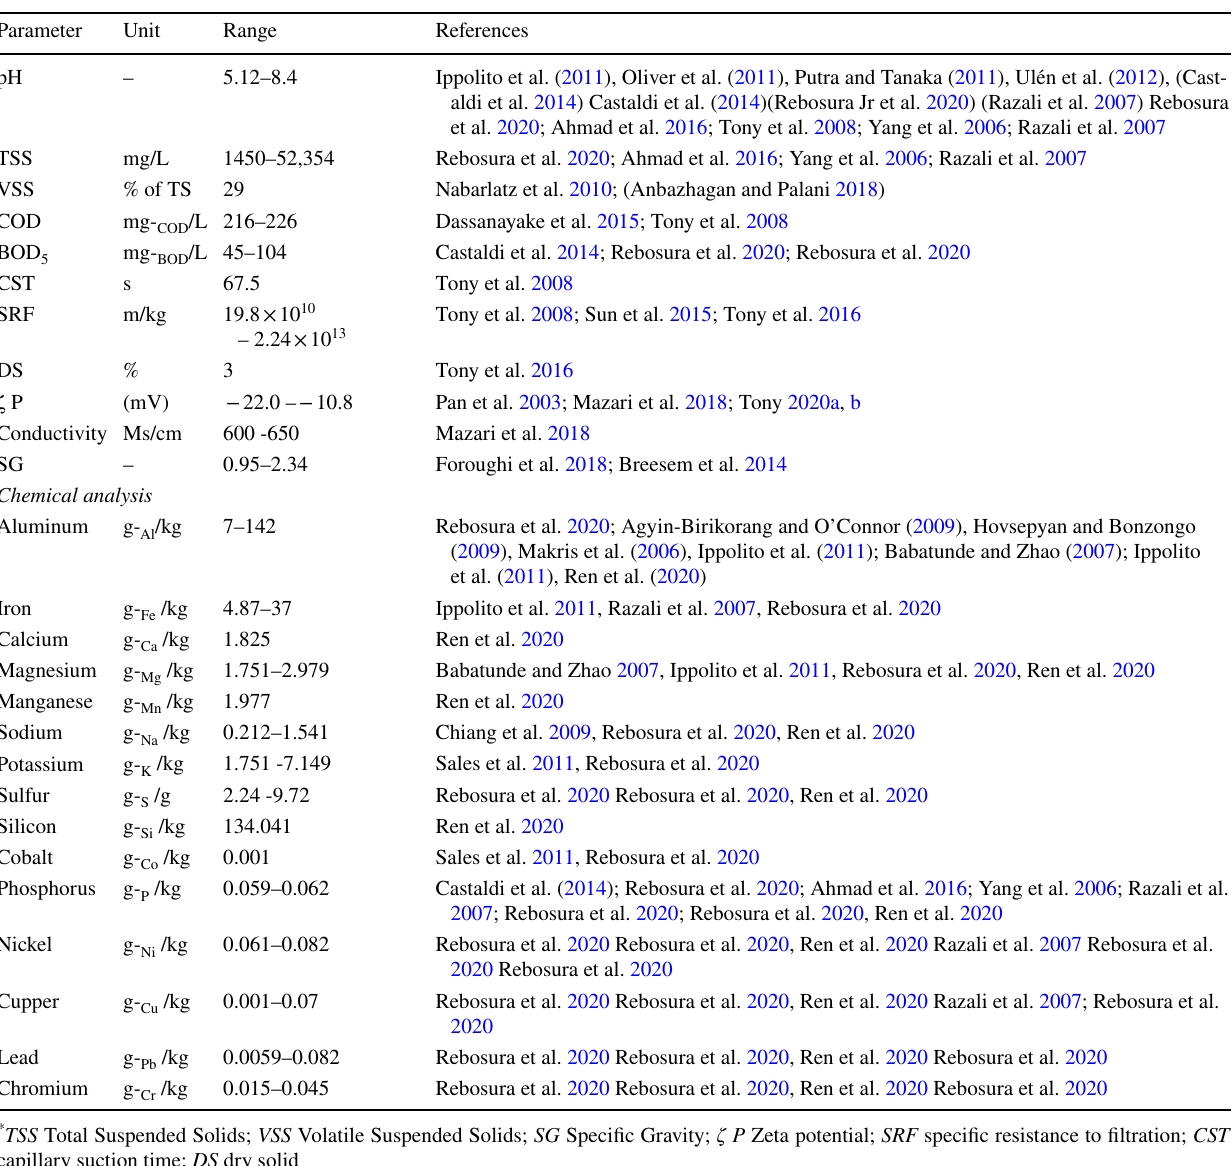
Table 1 Physicochemical characteristics and geotechnical properties of alum